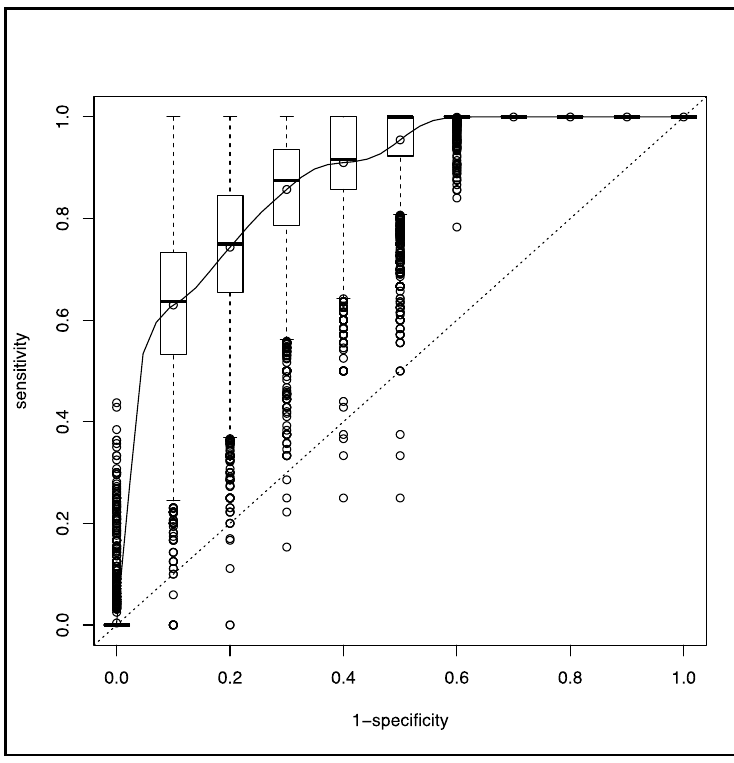
Figure 3. ROC curve of the pulse oximetry (SpO 2 ).